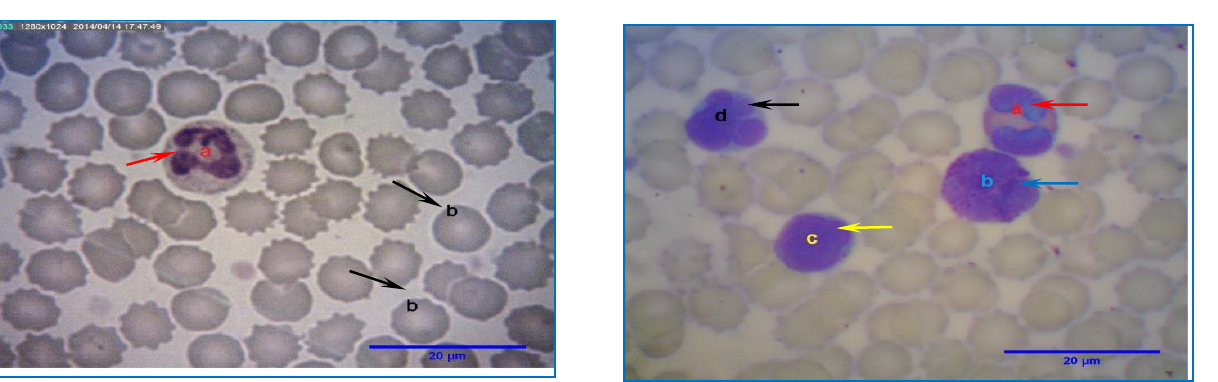
Figure, 5: (a) Eosinophil. (b) Basophil. (c) medium-sized lymphocyte. (d) dividing lymphocyte (100x × 1.3 megapixels).